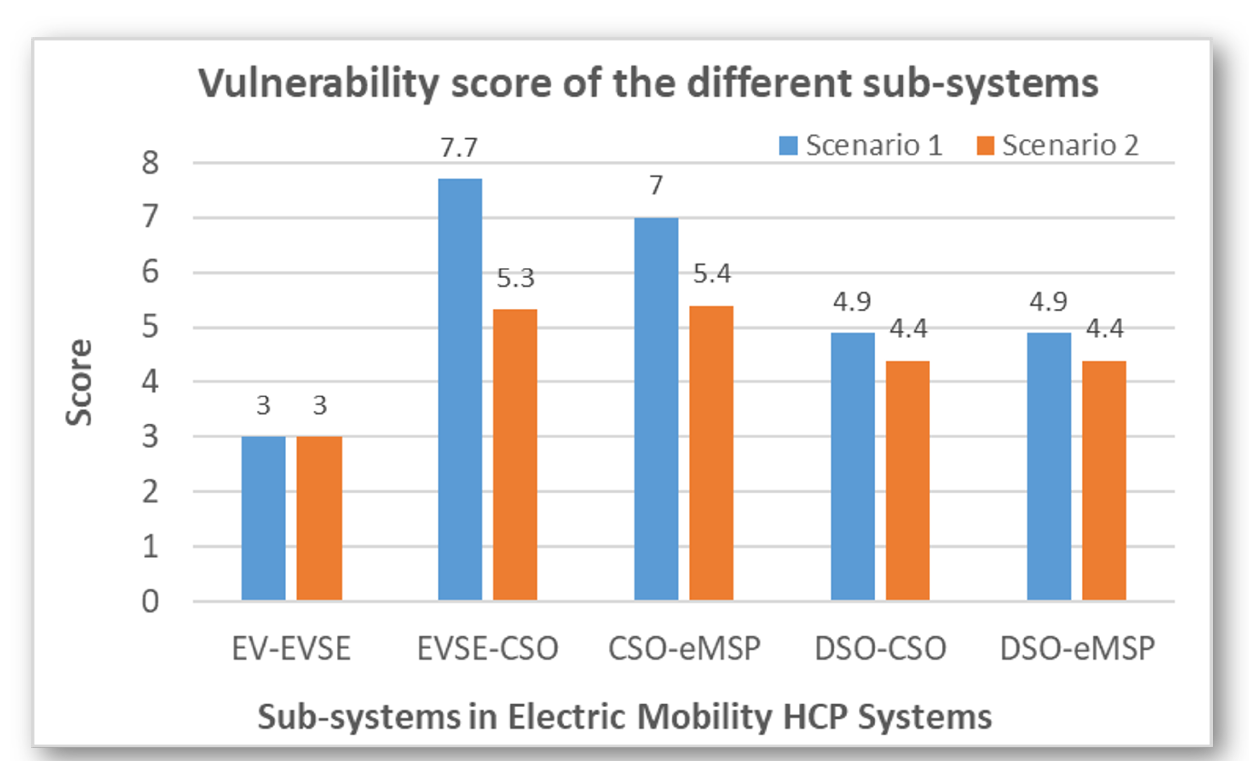
Figure 5. Summary of the vulnerability scores of the different sub-systems by considering two different scenarios. In case more than one vulnerability exist for each communicating sub-system, Scenario 1 and Scenario 2 consider the worst and average values to compute the overall vulnerability